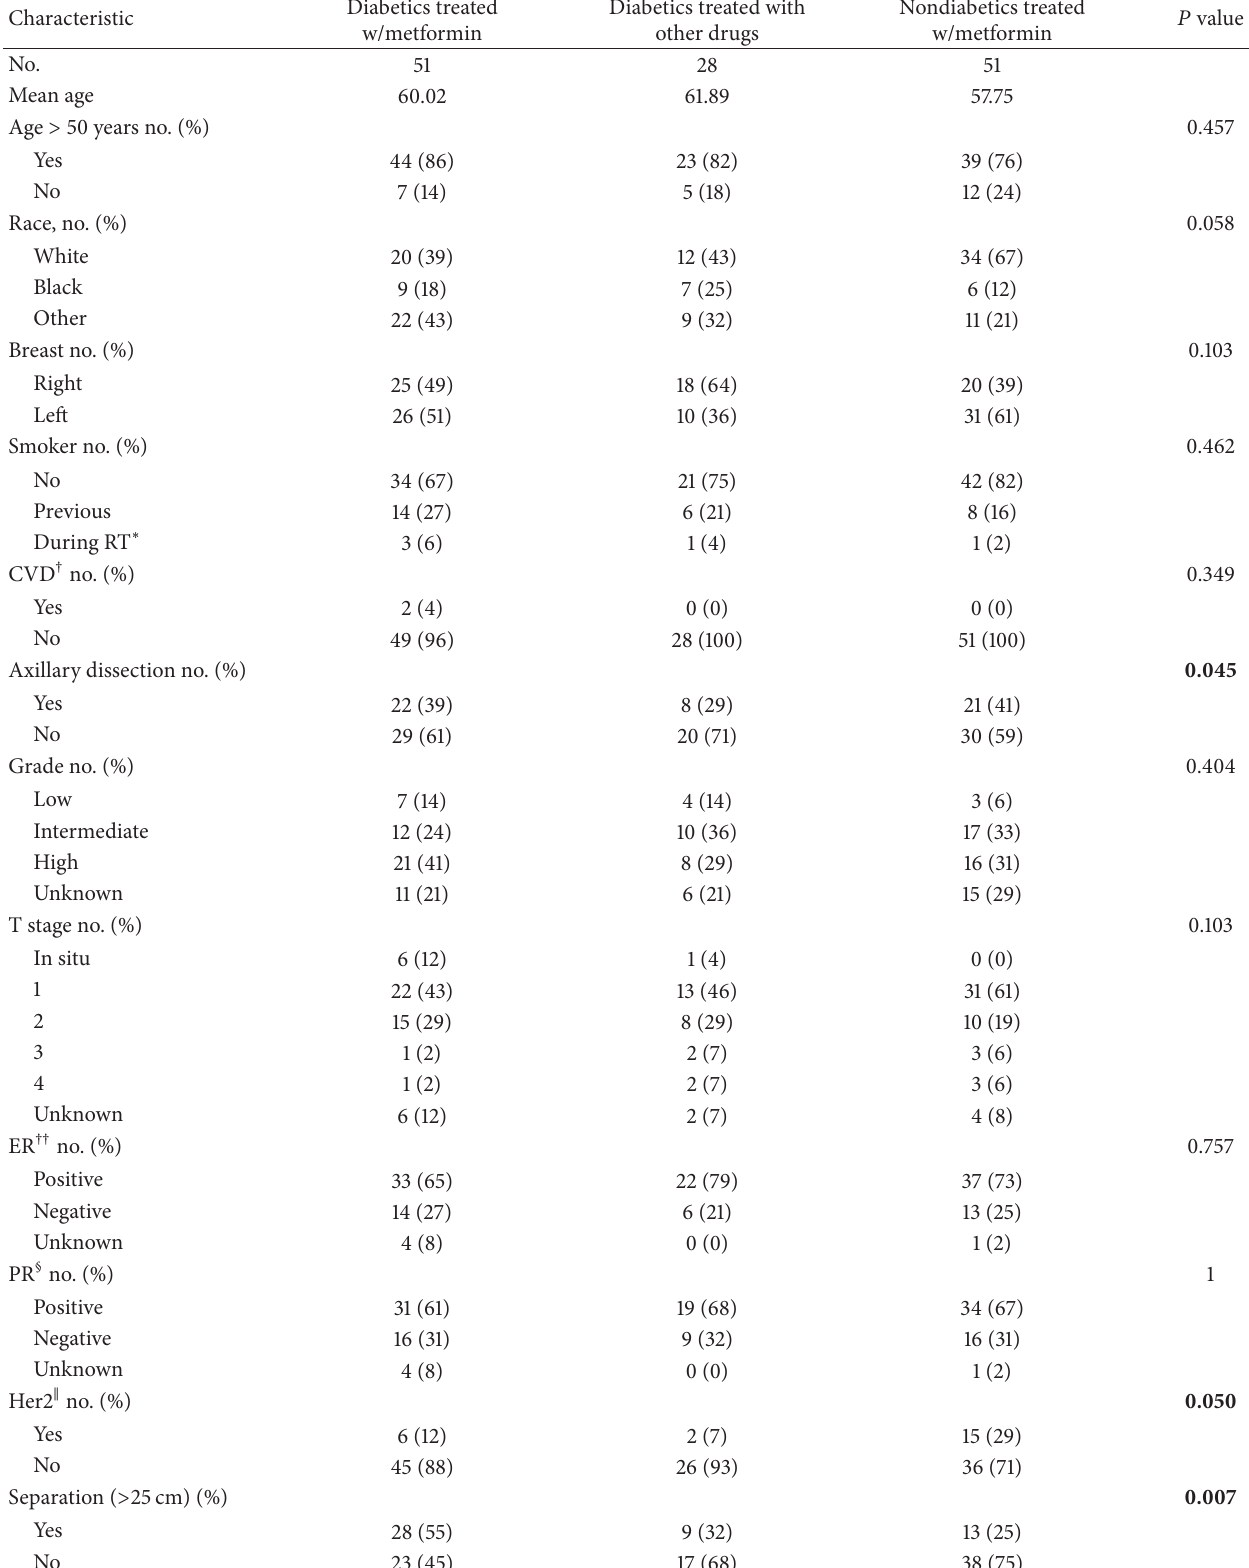
Table 1: Patient